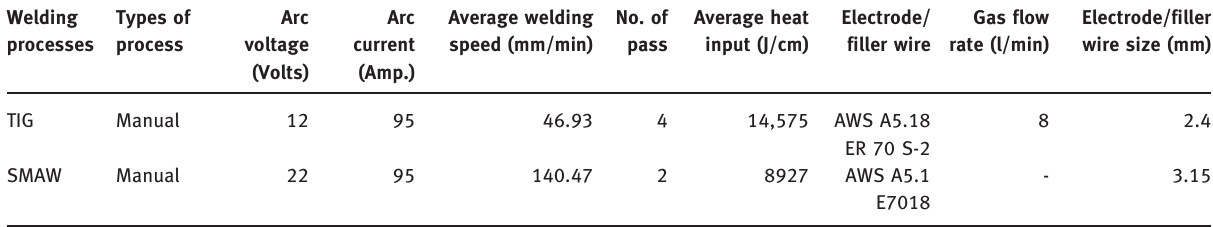
Table 1: Welding process parameters. Welding